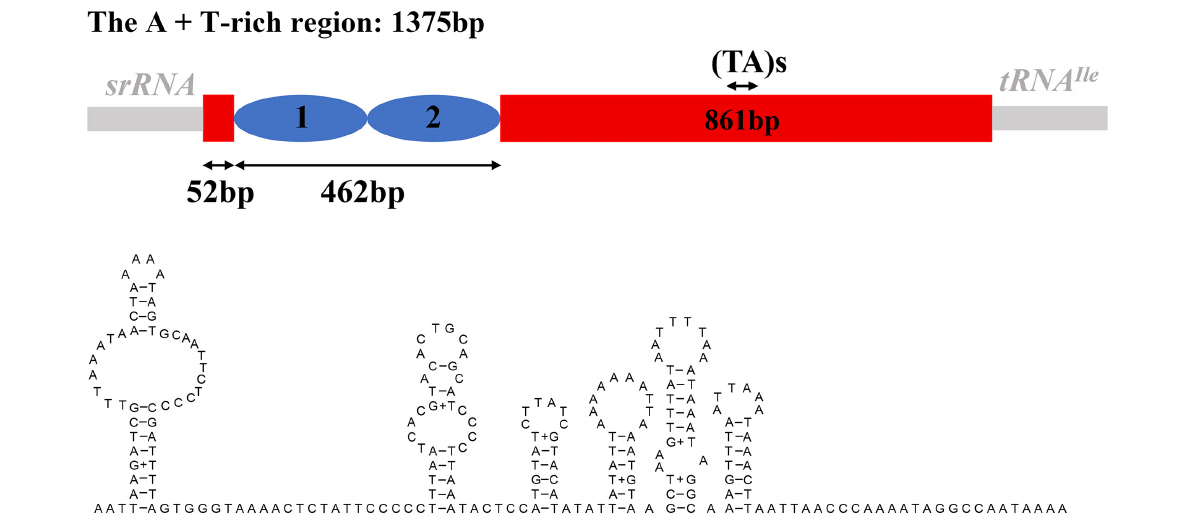
tRNA Ser ( AGN ) , which formed a loop. The amino acid acceptor (AA) arms of all tRNAs were 7 bp. The size of the T Ψ C (T)